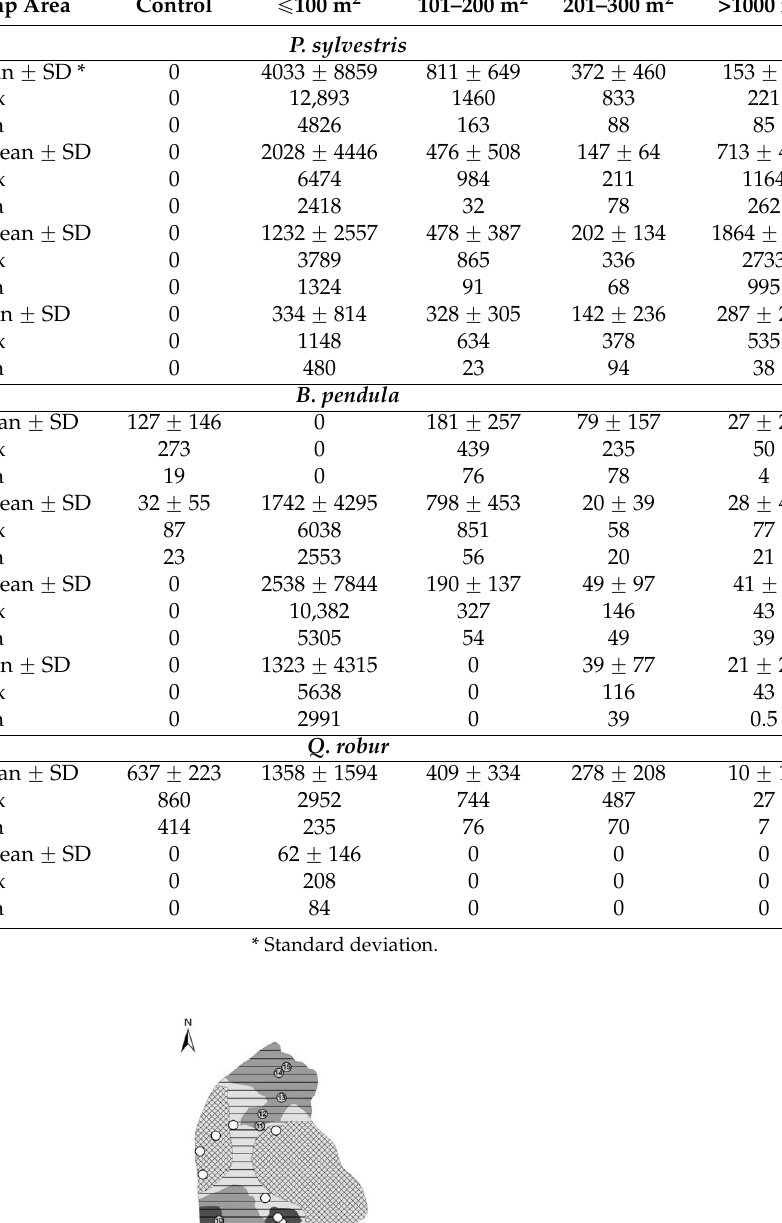
Table 2. Mean number of seedlings (<1.0 m) and saplings (>1.1 m) of P. sylvestris , B. pendula and Q. robur in gaps of different area classes and control plots (per ha). Height/Gap Area